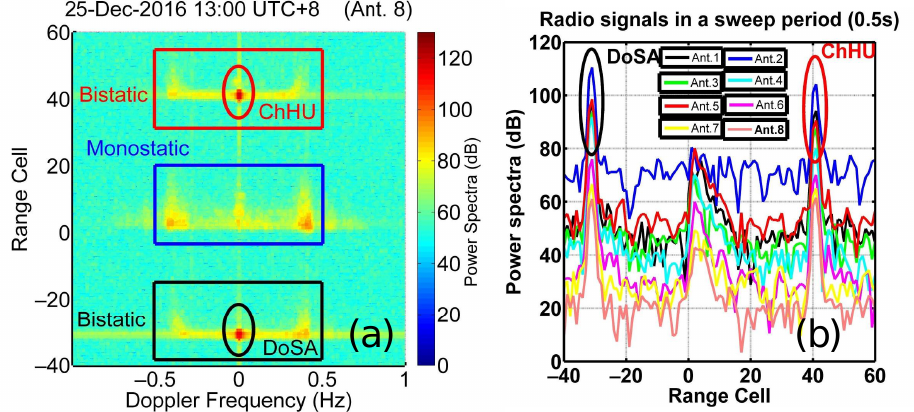
Figure 7. ( a ) Range-Doppler spectra at 1300 UTC+8 25 December 2016 including one monostatic (blue rectangle) and two bistatic measurements (red and black rectangles) received by the ship radar site (Ant. 8); ( b ) range spectra in a sweep period (0.5 s) including radio signals from the ChHU site (red ellipse) and the DoSA site (black